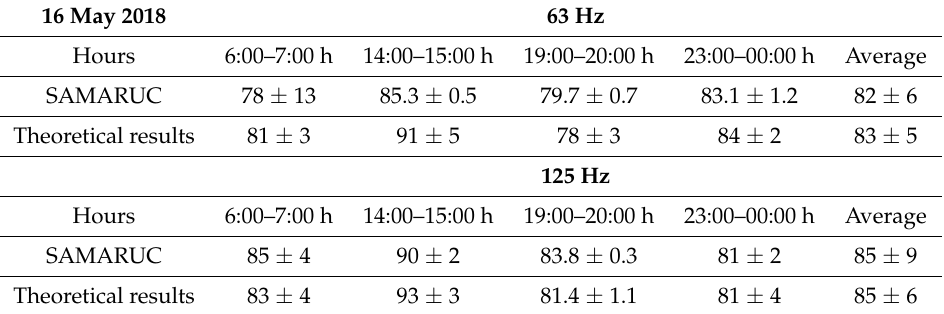
Table 3. dB SPL re 1 uPa comparison for 63 Hz and 125 Hz on